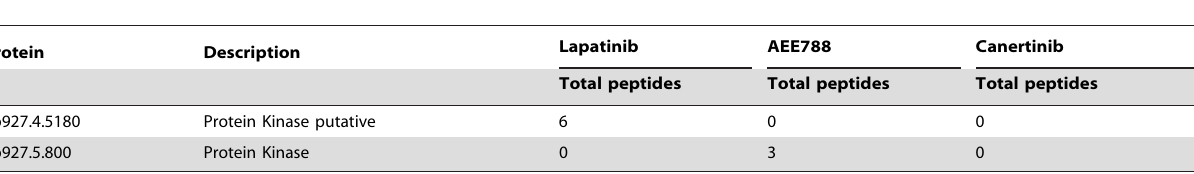
Proteins listed are detected at least twice in three separate affinity chromatography/mass spectrometry studies.